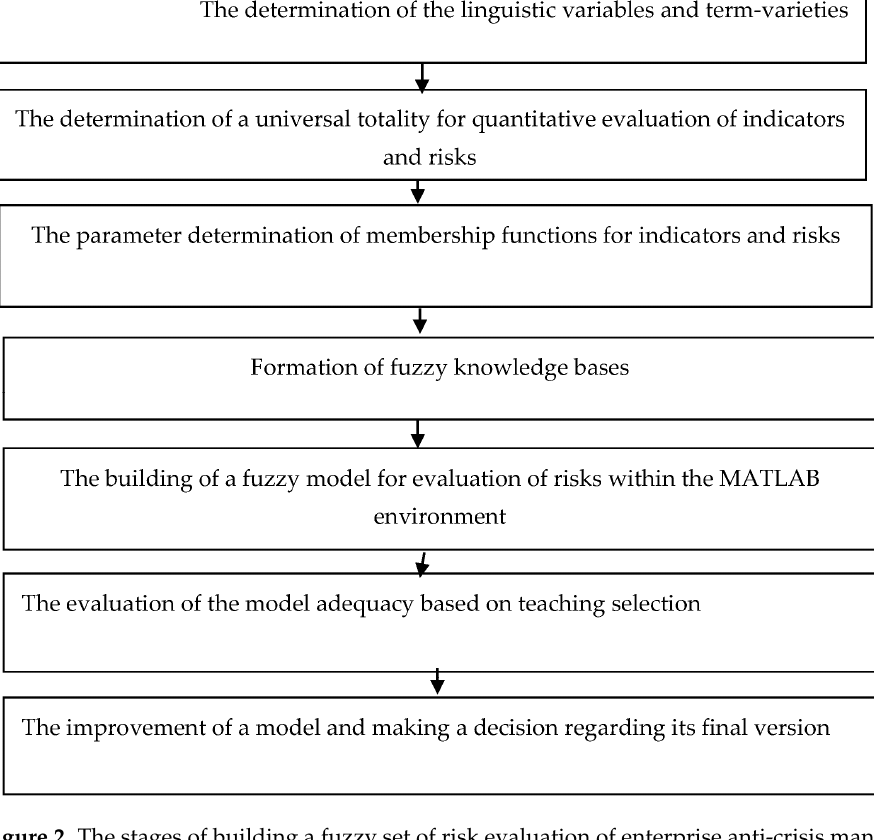
Figure 2. The stages of building a fuzzy set of risk evaluation of enterprise anti-crisis management. (the authors’ development).